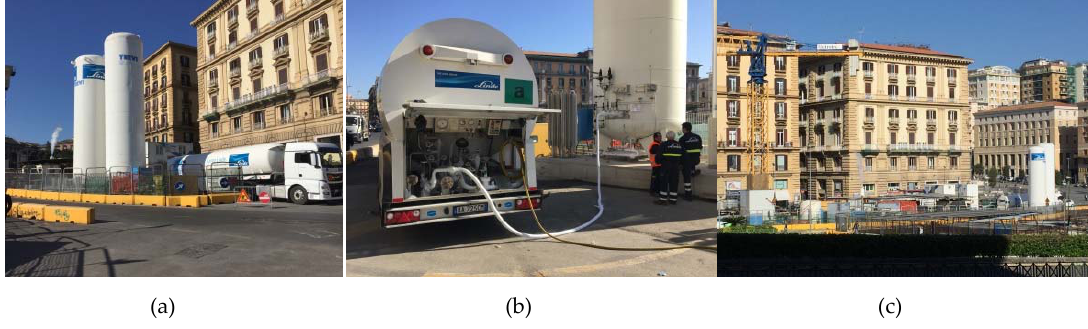
Figure 1. (a) Truck and tanks of liquid nitrogen; (b) loading of liquid nitrogen into the tanks; (c) view of the construction site. of the construction